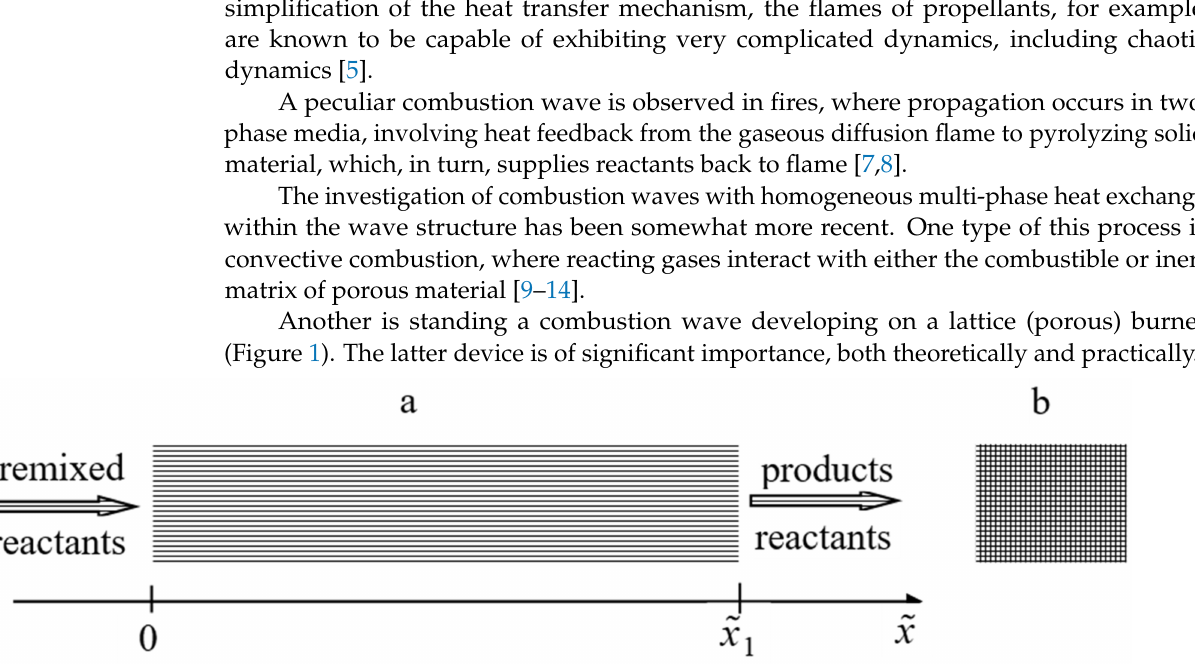
Figure 1. Schematic of the lattice burner considered: ( a ) side view (cross-section) and ( b ) front (upstream)